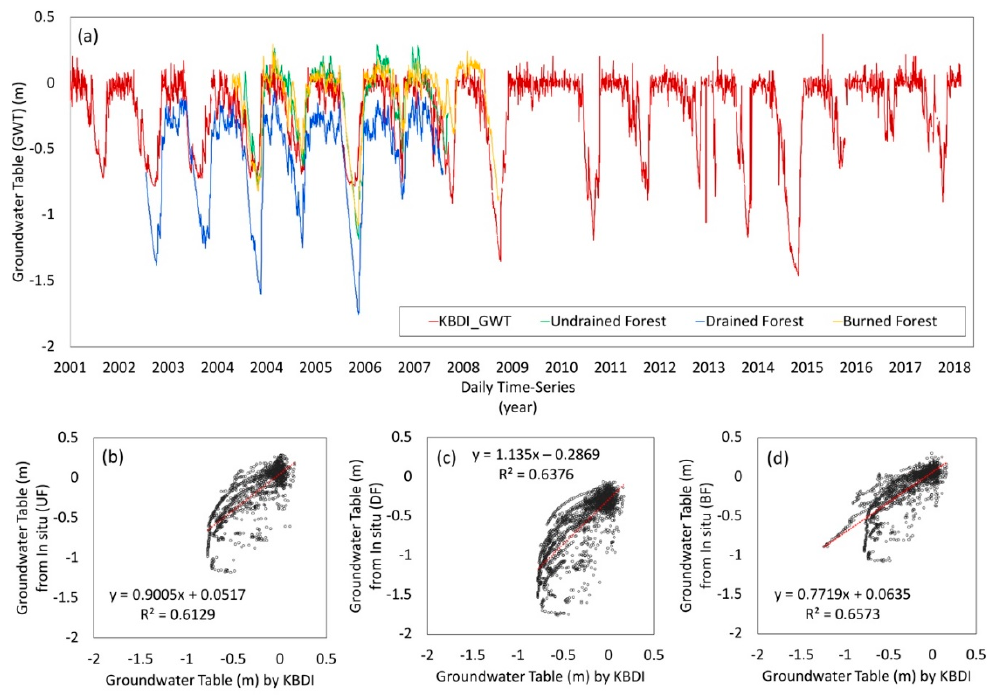
Figure 5. Satellite-based groundwater table (GWT) created by using the Keetch–Byram Drought Index (KBDI) and in situ measurements of the GWT at the Palangkaraya flux tower, Kalimantan, Indonesia. ( a ) Time series of the GWTs. Scatter plots of the GWTs between the KBDI-based one and the in situ one in ( b ) undrained forest (UF), ( c ) drained forest (DF), and ( d ) burned forest (BF) sites.